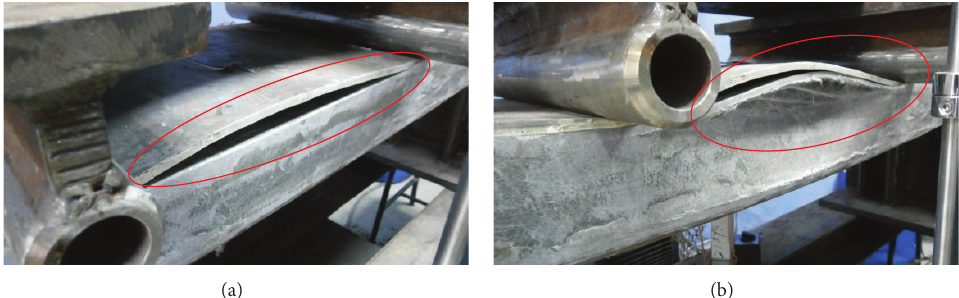
Figure 5: Failure of specimen S( 4 )-GFRP: (a) peeling off and delaminating and (b) tearing failure of the web where it intersected the facesheet.